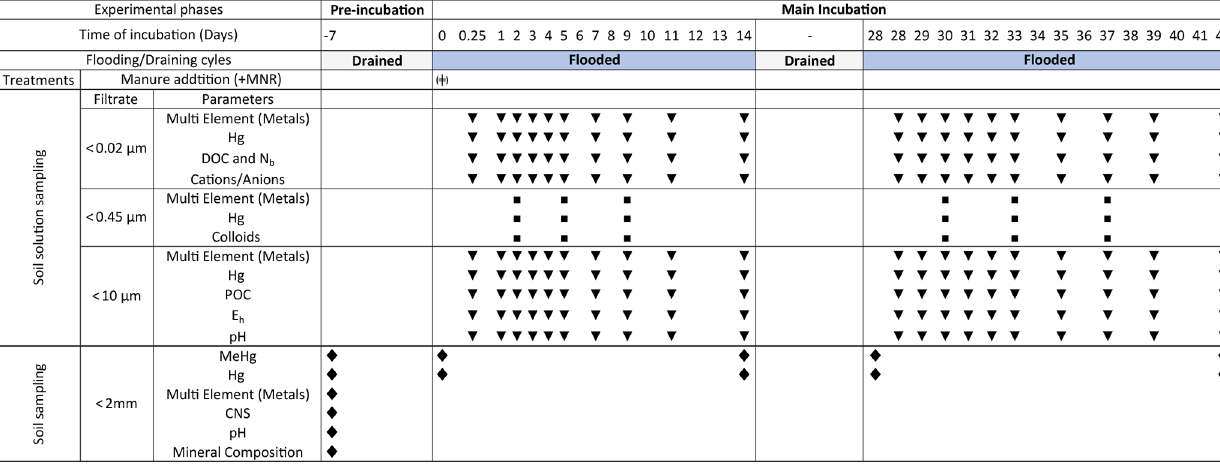
Figure 1. Schedule of preformed incubation experiment, samplings and measurements: blue bars indicate soil flooding periods. Gray bars represent drained periods. The width of the columns is not proportional to the time of incubation. In the treatments row the ( + ) symbol indicates the addition of liquid manure to the microcosms specifically treated with manure ( + MNR). Triangles represent regular soil solution sampling points. Rectangles represent soil solution sampling for colloid analyses. Diamonds represent time points for soil sampling. At − 7d, soil was sampled from the pooled soil directly before the